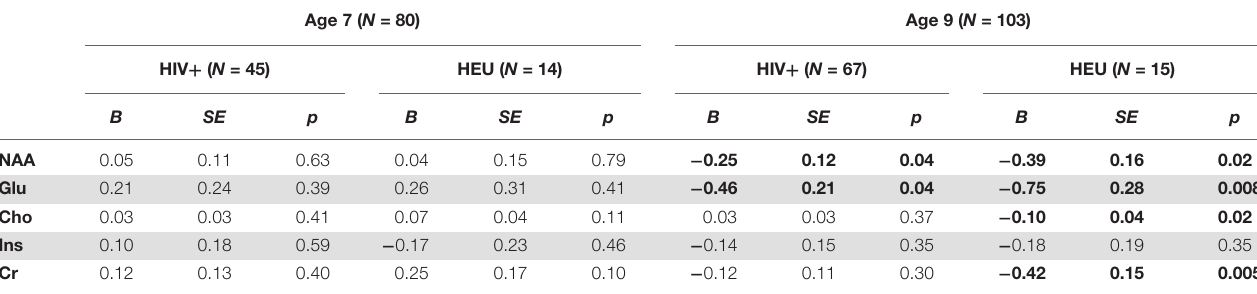
TABLE 3 | Unstandardised regression coefficients (B), standard error and p -values for basal ganglia absolute metabolite levels relative to control children at age 7 and 9, controlling for sex, age at scan, ethnicity, and voxel gray matter content. Age 7 ( N = 80) Age 9 ( N = 103)